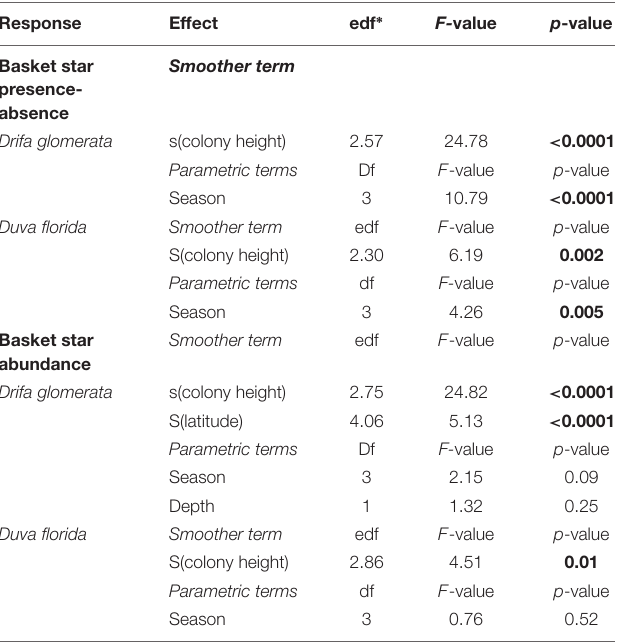
TABLE 4 | Statistical outputs of GAMM models on the effects of soft coral colony height (smoother) and season on juvenile basket star abundance and presence-absence on Nephtheidae soft corals in the Northwest